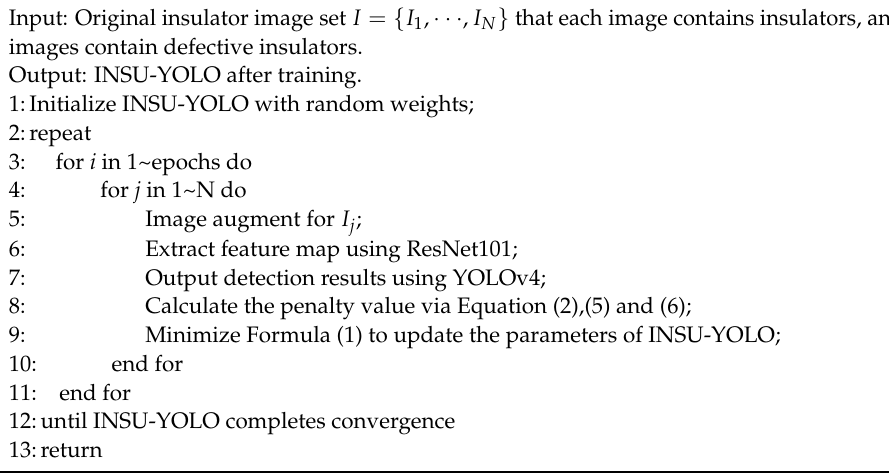
Algorithm 1. The training process of